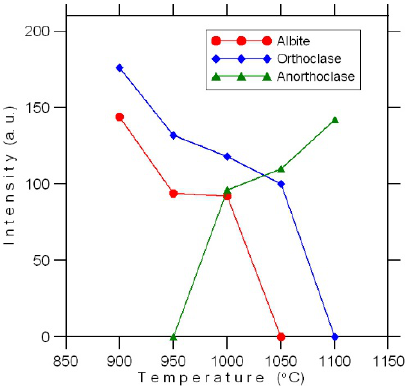
Figure 3. Feldspars of the ceramic samples at different temperatures.